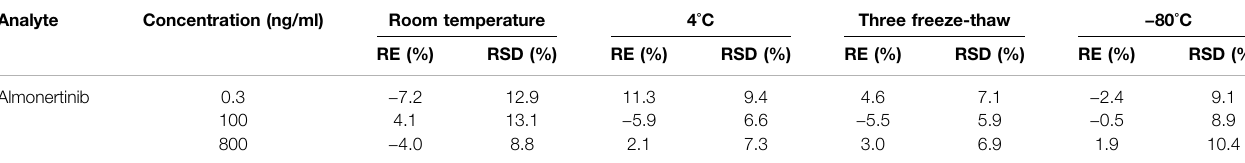
TABLE 4 | Summary of the stability of almonertinib in rat plasma under different storage conditions ( n = 6). Analyte Concentration (ng/ml)